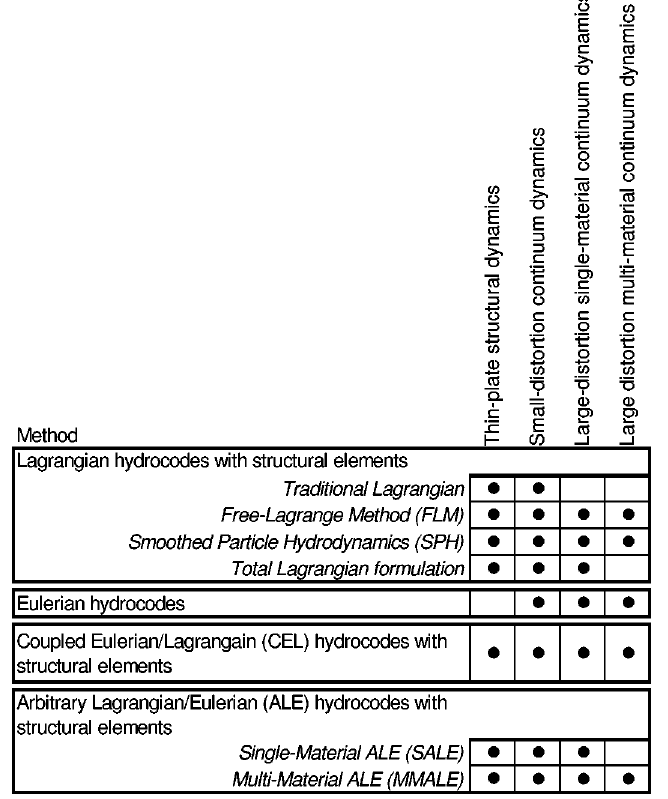
Potential SMI applicabilities of hydrocode